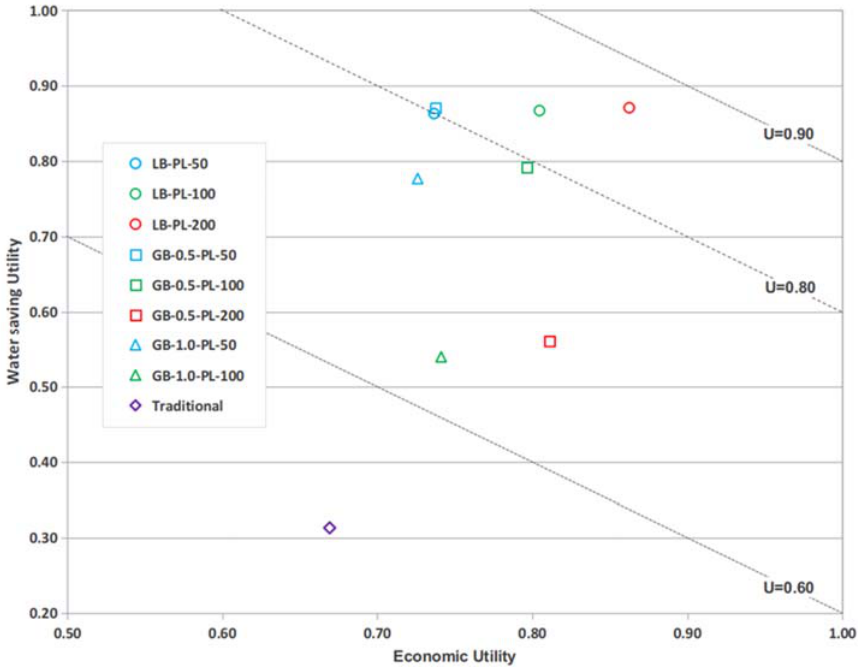
Figure 8. Evaluation of alternatives considering the joint effects of the economic and water saving utilities on the global utility of the best project alternatives for a medium infiltration soil and for medium inflow rates. Isolines of the global utility 0.60, 0.80, and 0.90 are included.